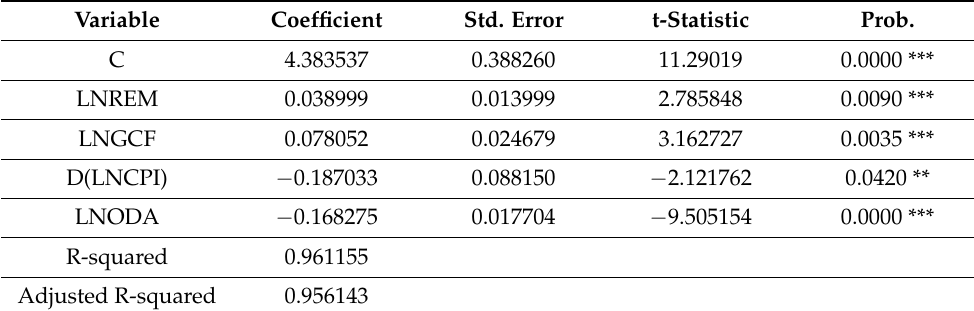
Table 2. OLS linear multiple regression results (log of GDP per capita is the dependent